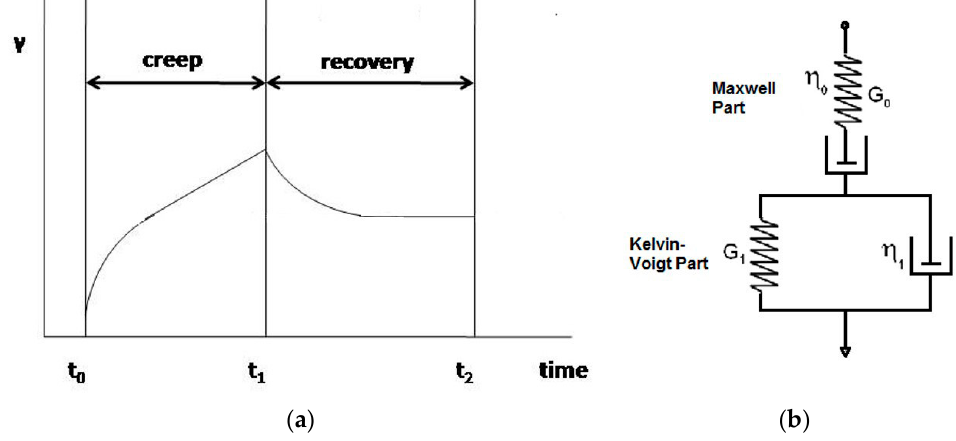
Figure 4. ( a ) Typical curve strain ( γ ) in function of time creep-recovery test for a viscoelastic material and ( b ) the four elements of Burger’s model.